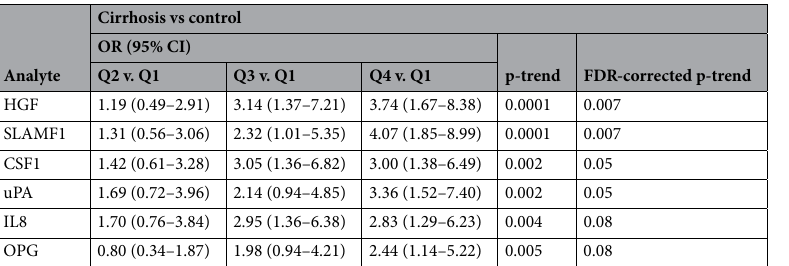
Table 2. Odds ratios* and 95% CIs for associations between selected markers and cirrhosis versus non- cirrhotic controls. *Adjusted for age, sex, years of follow up, HBV viral load, serum alanine aminotransferase (ALT) level, alcohol, smoking, and HBV e antigen